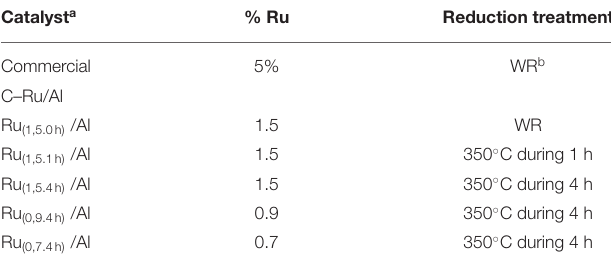
TABLE 1 | Ru/Al based catalysts: commercial and synthesized.